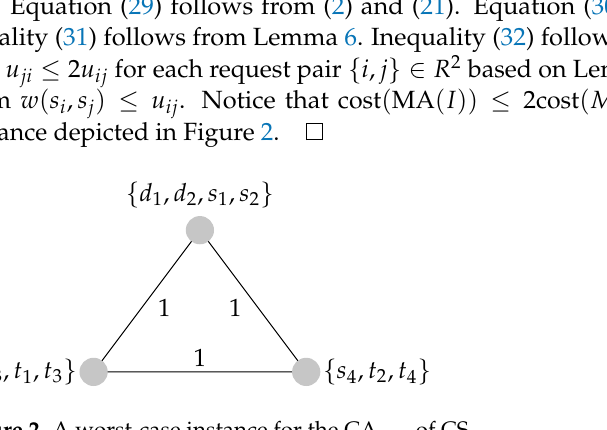
Figure 2. A worst-case instance for the CA sum of CS sum